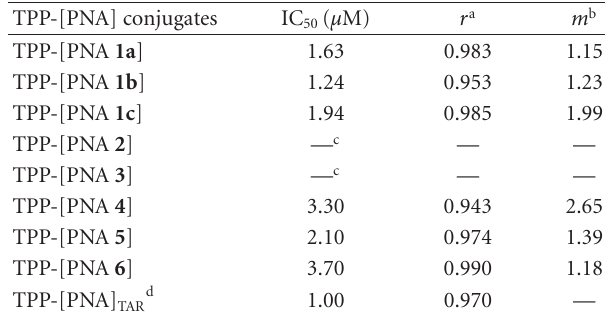
Table 2: IC 50 values for TPP-[PNA]